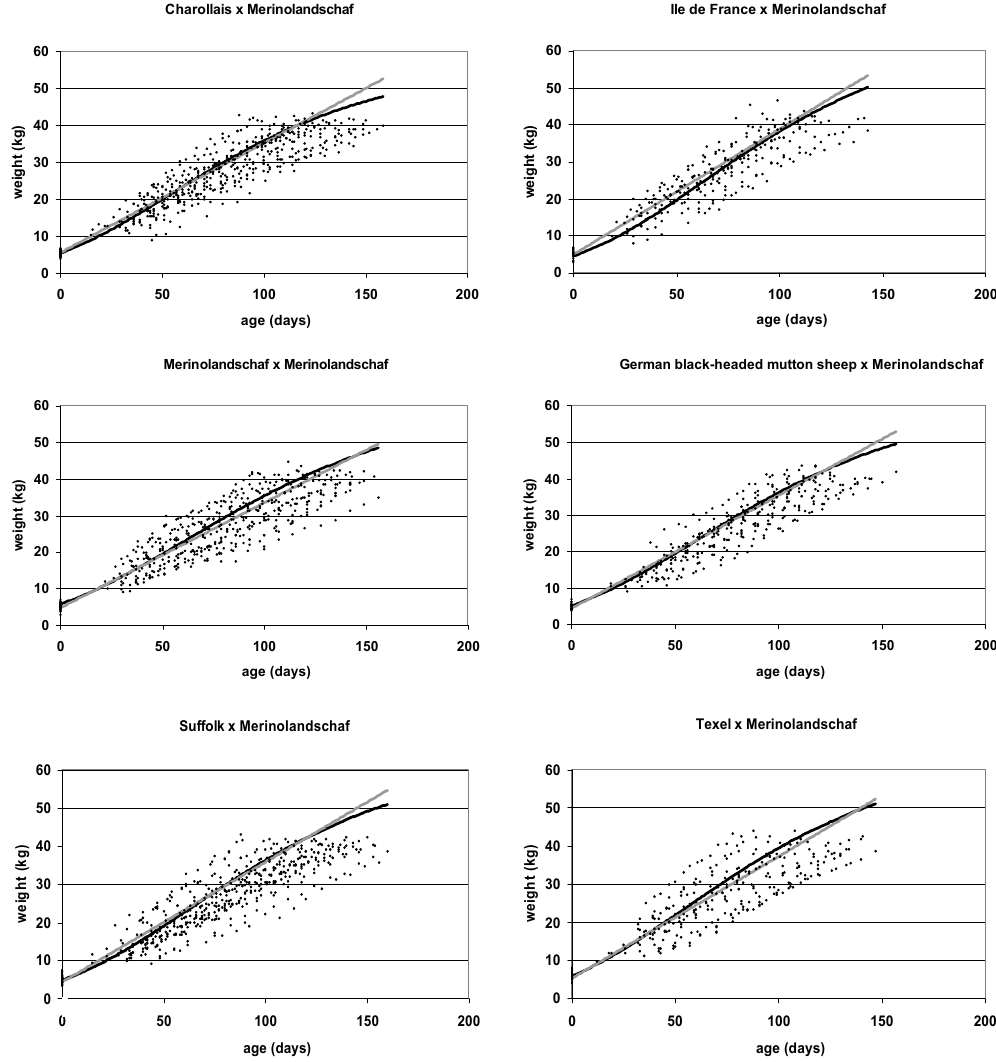
Figure 1. Estimated growth function for Gompertz (black) and linear model (grey) for different crossbred lambs and purebred Merinoland- schaf lambs; body weight (kg) plotted against age